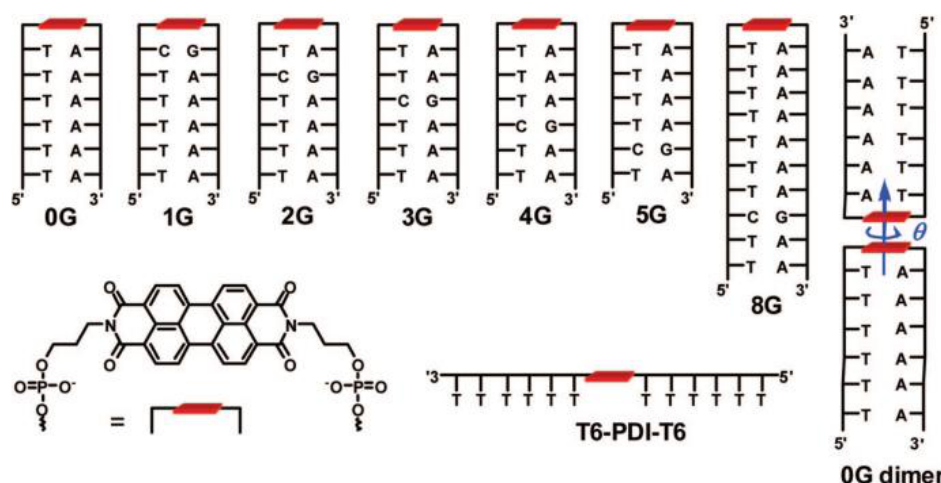
Figure 8. Schematic representation of PDI – DNA conjugates and structures of the PDI chromophore modified with phosphate at imide positions [77]. Copyright © 2009, American Chemical Society.